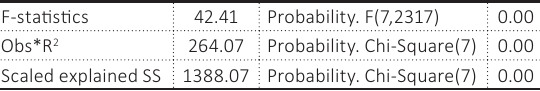
Table 4. Heteroscedasticity test: